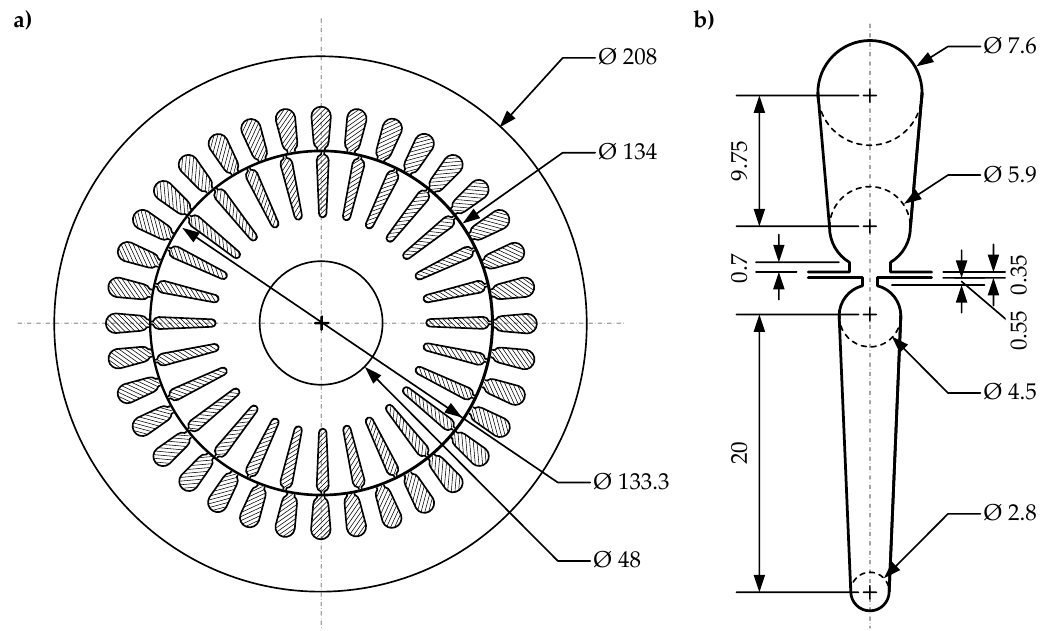
Figure A1. The cross-section dimensions: ( a ) the squirrel-cage IM of type Sg 132S-4 and ( b ) stator and rotor slots of the squirrel-cage IM of type Sg 132S-4.